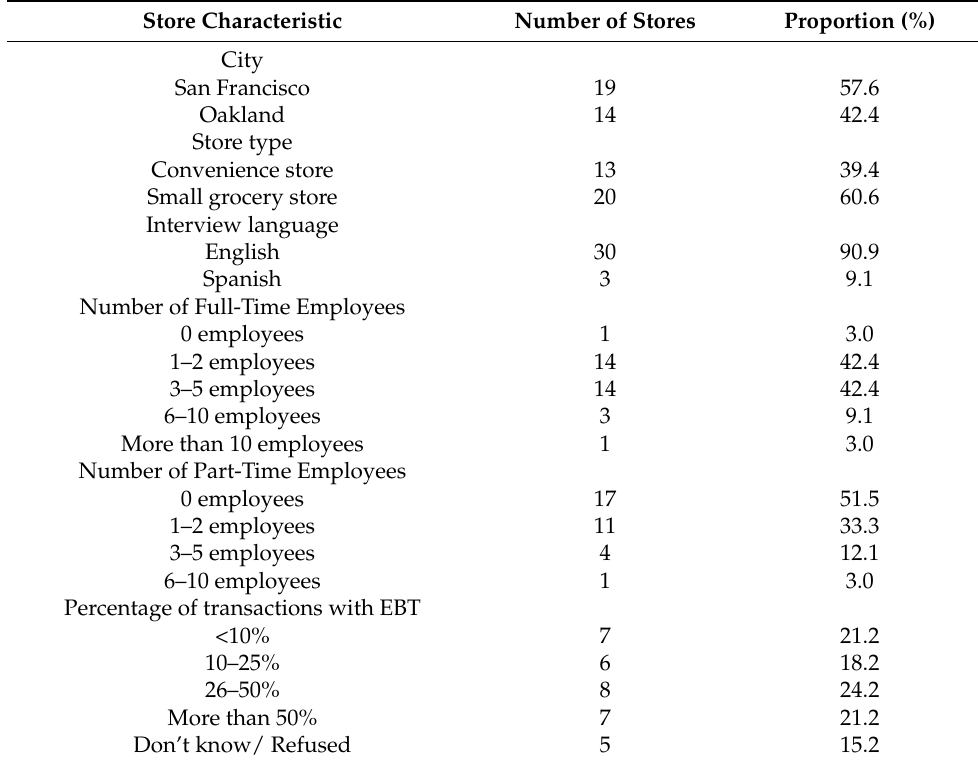
Table 1. Characteristics of small food